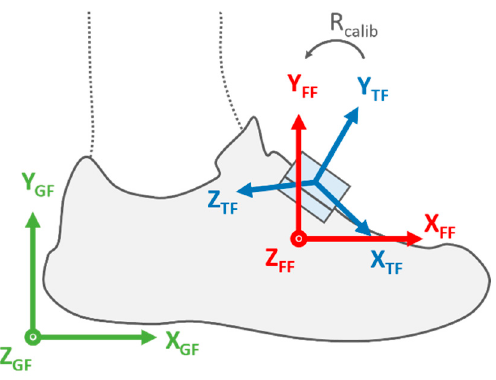
Figure 2. The orientation of the IMU technical frame (blue), the foot functional frame (red) and global frame (green) when standing. R calib is the rotation matrix obtained by the functional calibration.